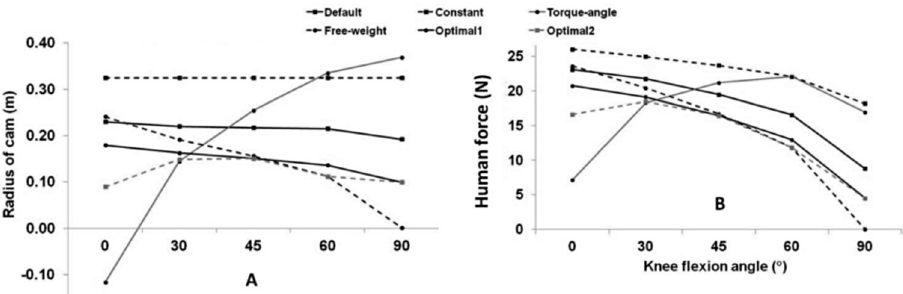
Figure 3 - A- Cam radius estimated by simulation modelling. Results from the default machine, simulation of constant cam radius, torque angle profile (5), free-weight profile, and two optimized models (optimal 1 and optimal 2). B- Human force required to overcome external torque applied to the shank during knee extension. Results from the default machine, simulation of constant cam radius, torque angle profile (5), free-weight profile, and two optimized models (optimal 1 and optimal 2).